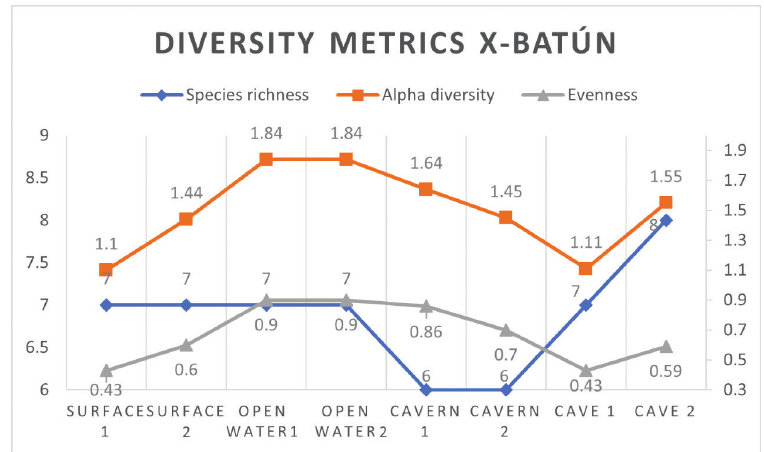
Figure 4. Benthic fauna diversity metrics along an environmental gradient in cenote